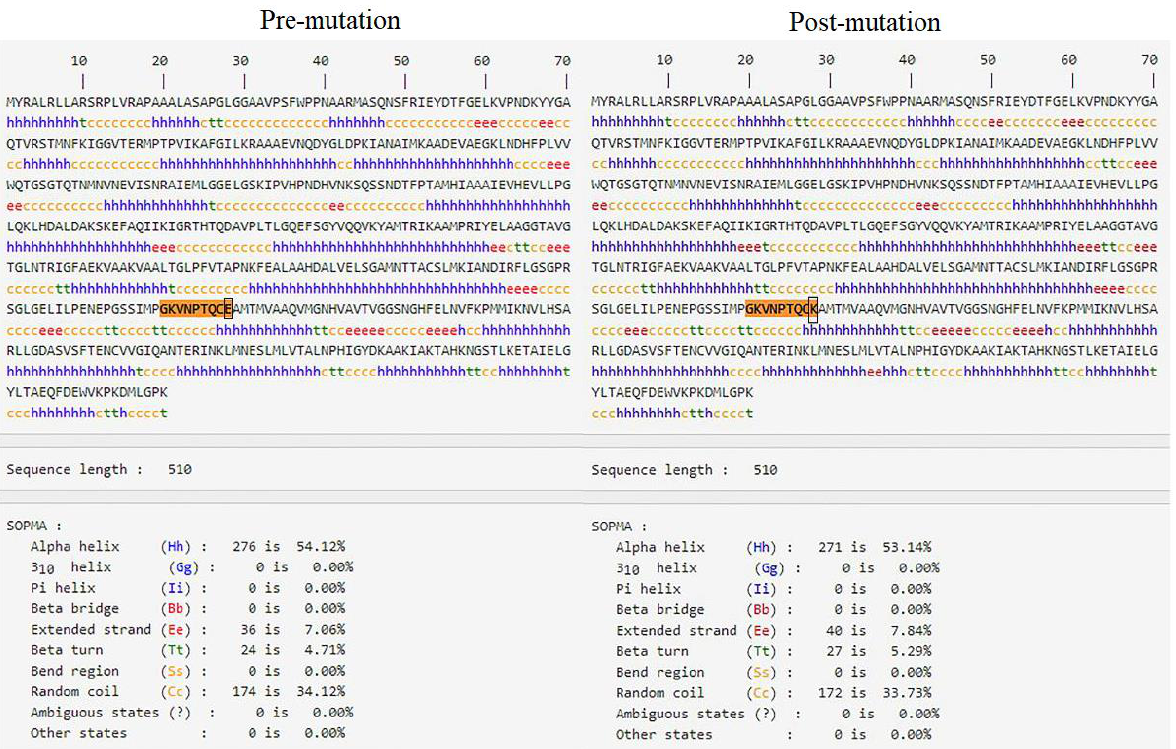
Table 1. Prediction of protein function. a A larger score (close to 1) of PolyPhen2 revealed a probably